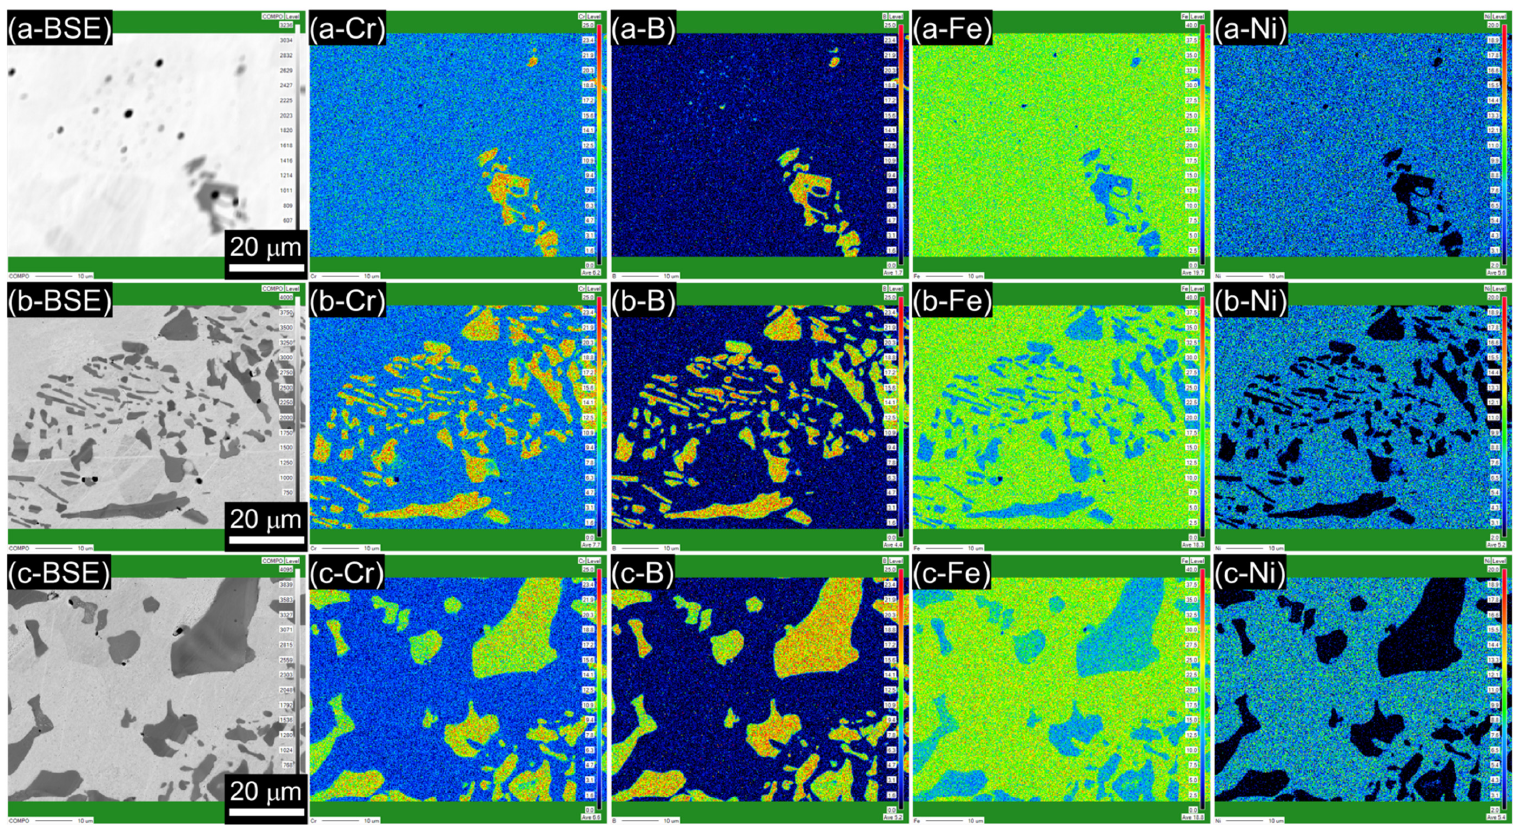
Figure 3. Elemental X-ray mapping of Cr, B, Fe, and Ni along with the corresponding back-scattered electron (BSE) images of the ( a ) B019, ( b ) B078, and ( c ) B176 alloys.